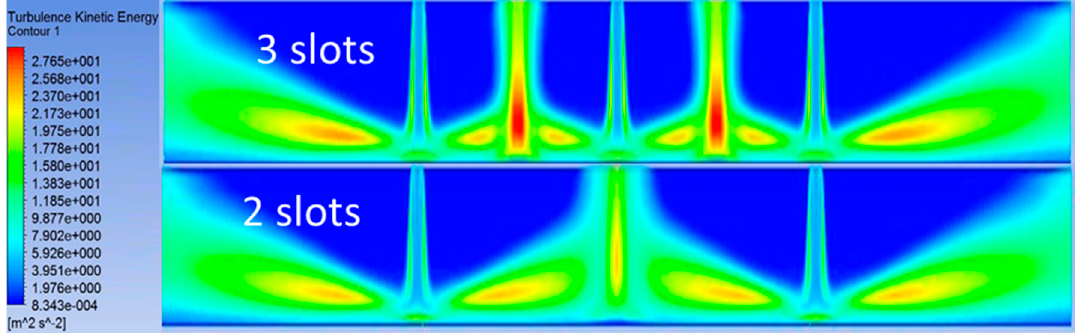
Figure 14. Turbulent kinetic energy contours of multi slot jet configuration with H/B = 4, Re = 5500 and realizable k- ε model: three slots ( upper ) and two slots ( down ).